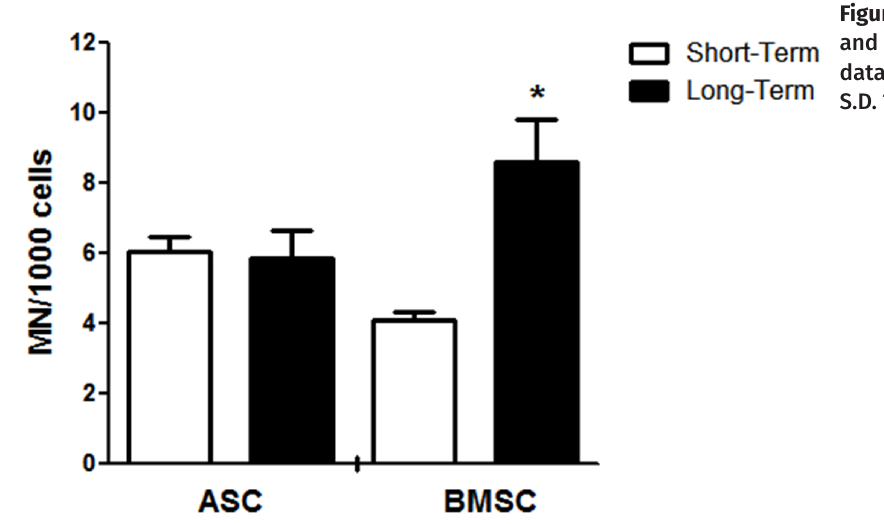
Figure 4. Micronuclei in short- and long-term ASC and BMSC data is presented as mean ± S.D. * p <0.05 (n =